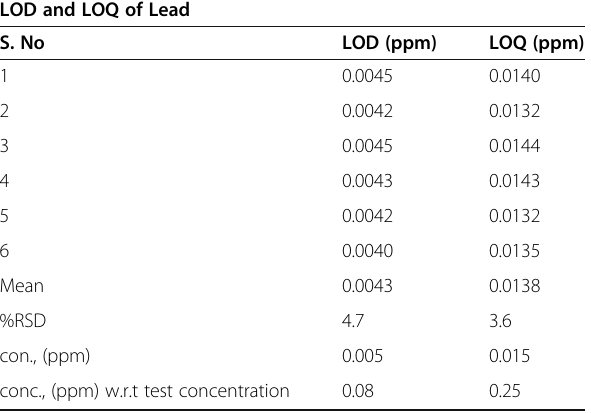
Table 3 LOD and LOQ experiments of Lead LOD and LOQ of Lead